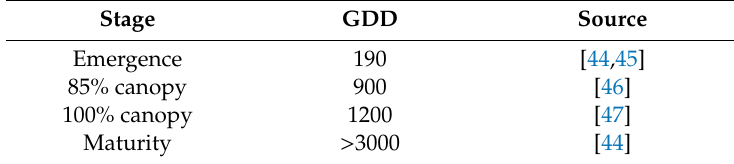
Table 1. GDD (Growth degree-day after sowing) for each sugar beet growth stage. Date of crop emergence was defined as the date on which 50% of seedlings had